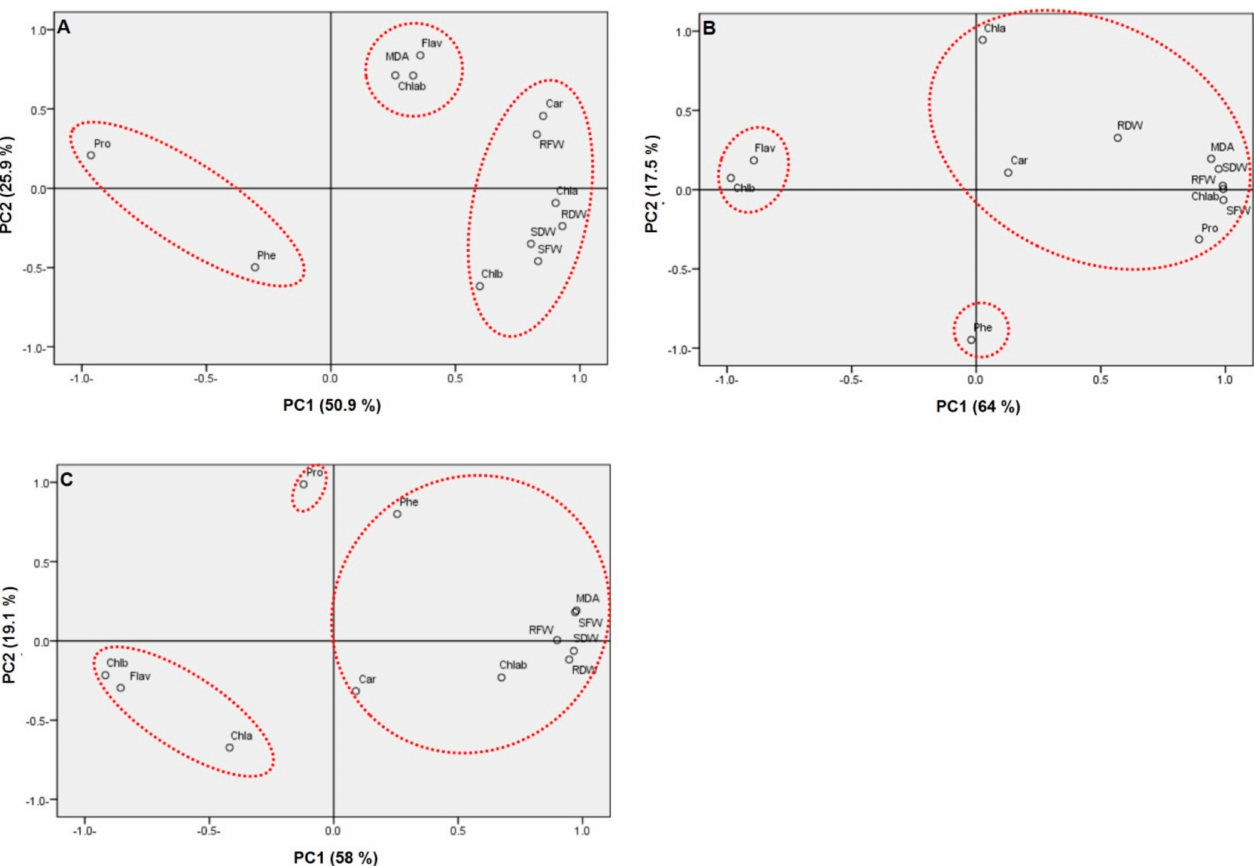
Figure 15. Principal components analysis bi-plot. Values of the studied parameters were analyzed under salinity (100 mM NaCl) with respect to control. Growth parameters (shoot fresh weight: SFW, root fresh weight: RFW, shoot dry weight: SDW, root dry weight: RDW), chlorophyll a: Chl a, chlorophyll b: Chl b, Chl a/b, carotenoids: Car, Proline: pro, malondialdehyde: MDA, phenolics: Phe, Flavonoids: Flav. In ( A ) Salicornia europaea, ( B ) Sarcocornia fruticosa , and ( C ) Arthrocnemum